Question: What caption would you write for this figure?
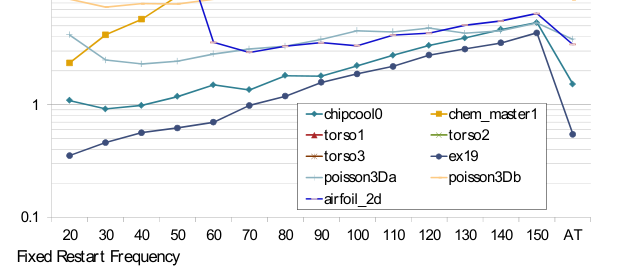
Answer: Auto-tuning Effect of Restart Frequency for  OpenATI_EIGENSOLVE(Arnoldi) on the T2K (16 threads).